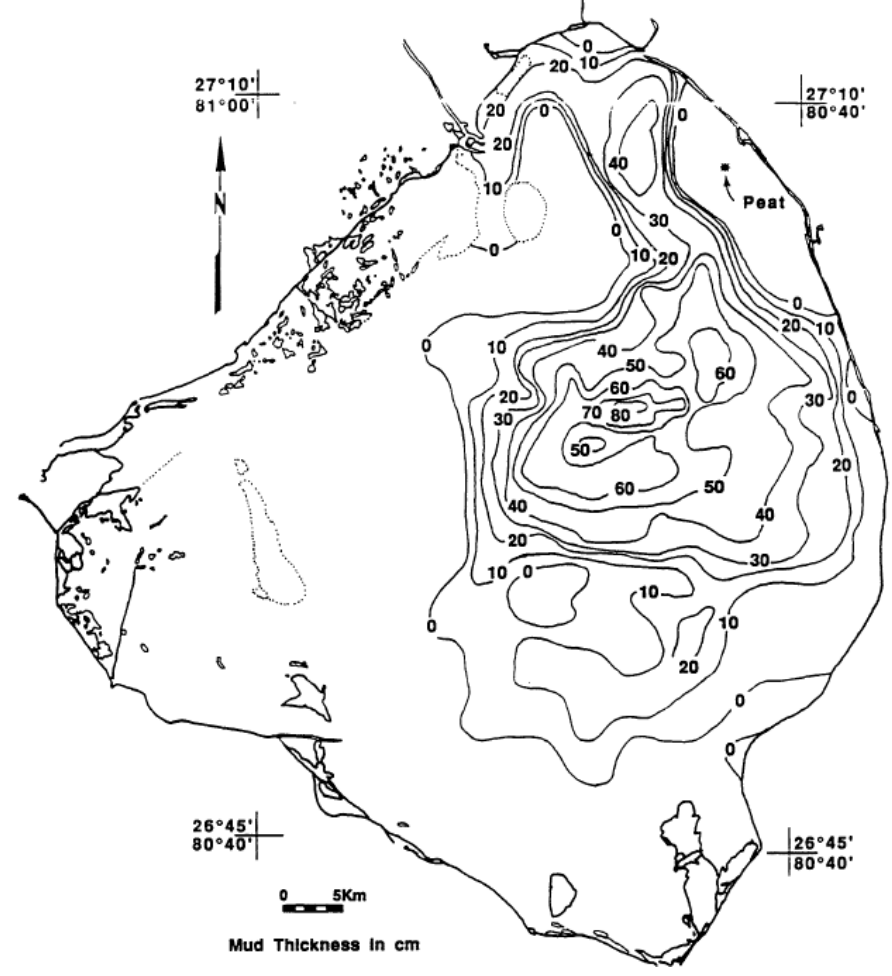
Figure 4. Thickness of organic mud on the bottom of Lake Okeechobee in 1989 [16].